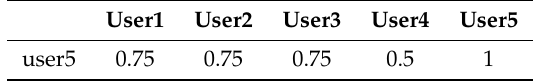
Table 2. Example of similarities between user 5 and all